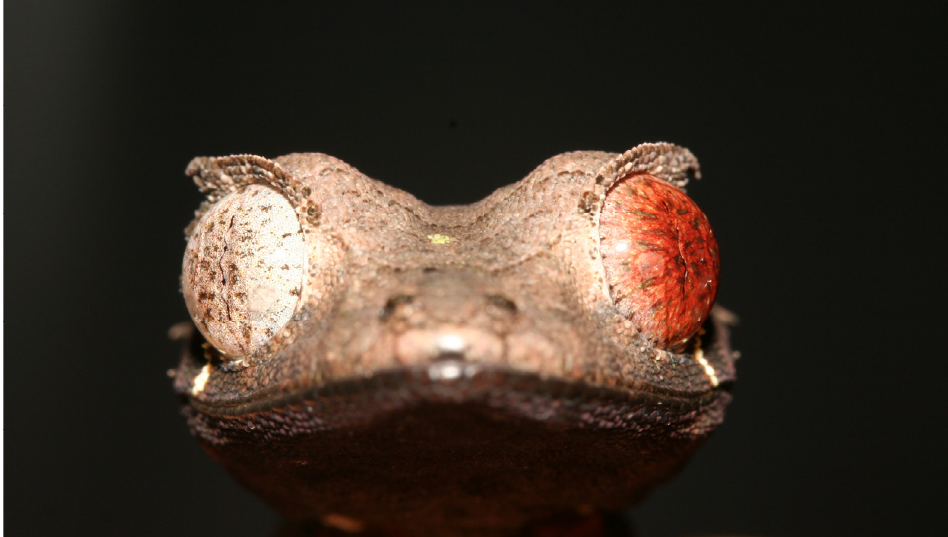
Figure 6. Unilateral dilation of iris vessels in the left eye of a satanic leaf-tailed gecko ( Uroplatus phantasticus ) can occur as a transient physiological phenomenon.